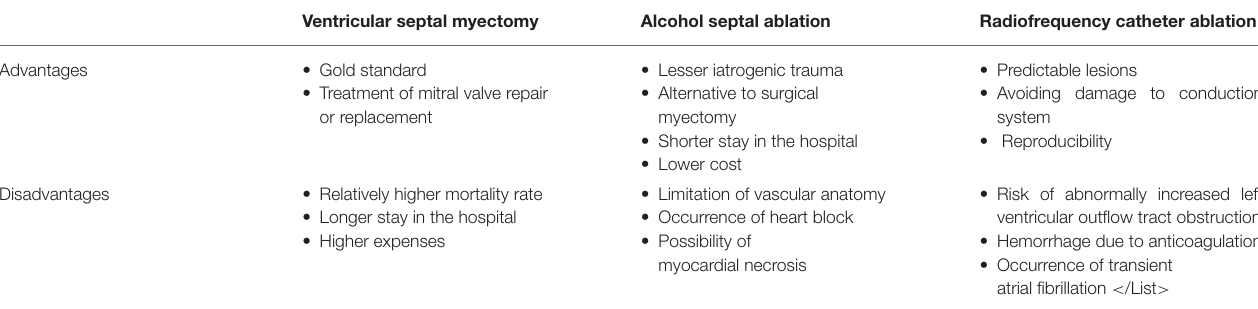
TABLE 1 | Advantages and disadvantages of different operative